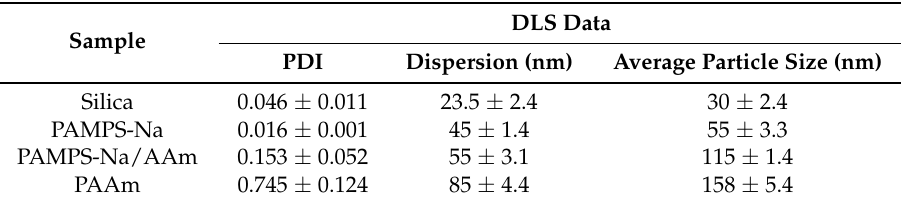
Table 1. Dynamic light scattering (DLS) data of silica-nanogel composites.